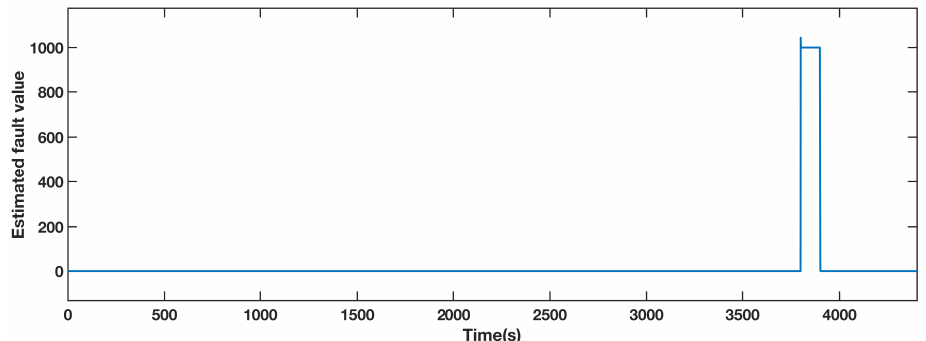
Figure 9. Estimated fault value from adaptive observer designed for the generator